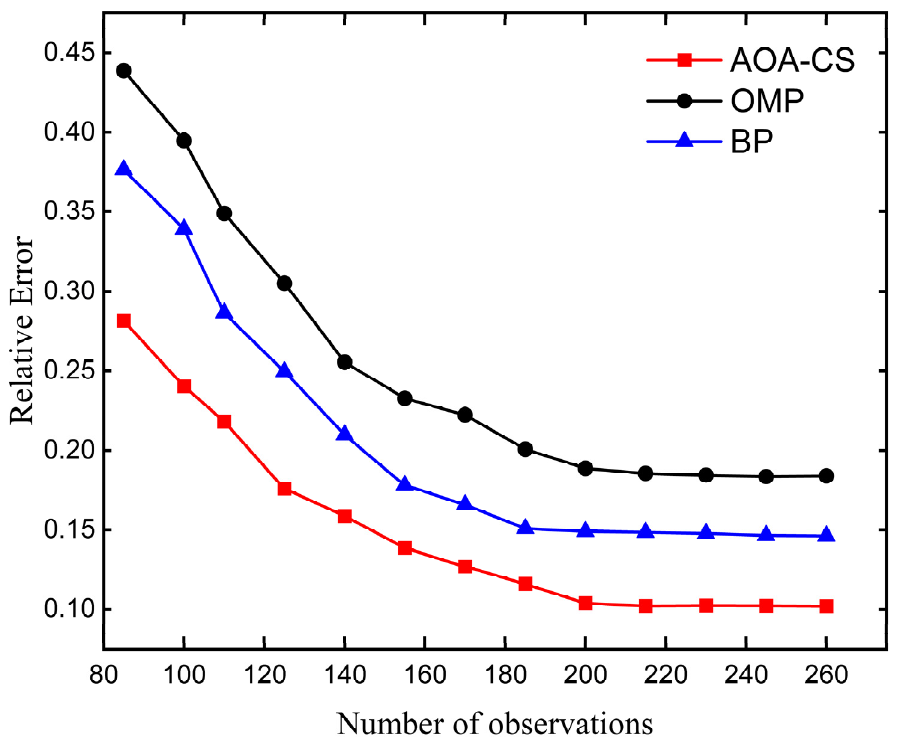
Figure 5. Relative error of reconstruction of each algorithm when the measured value changes.